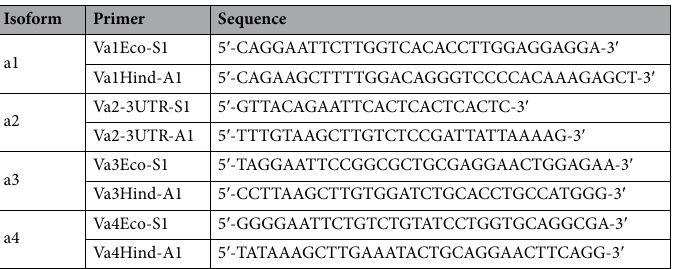
Table 1. Primers used in preparation of probes. The PCR products were digested with restriction enzyme Hind III and EcoRI and then subcloned into